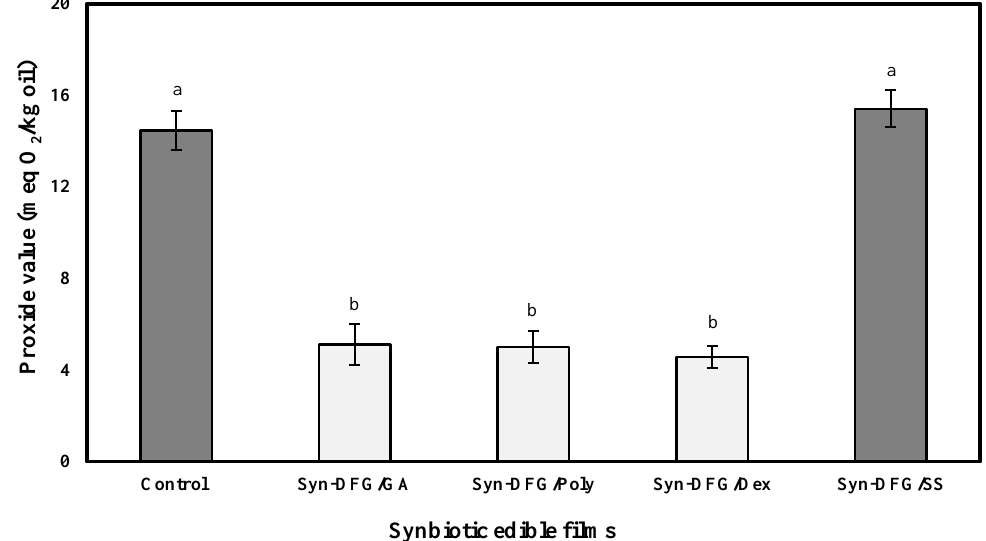
Figure 6. Prevention against oxidation of synbiotic edible films. a–b: Different letters on each column indicate significantly different values ( p < 0.05) following Duncan’s post hoc means-comparison test.